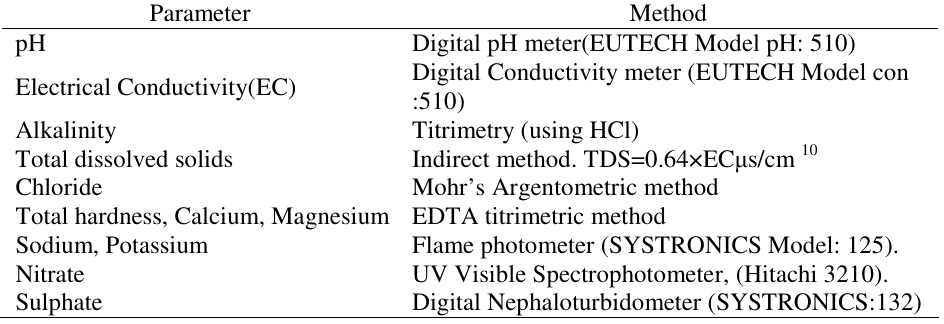
Table 1. Analytical methods for quality parameters of